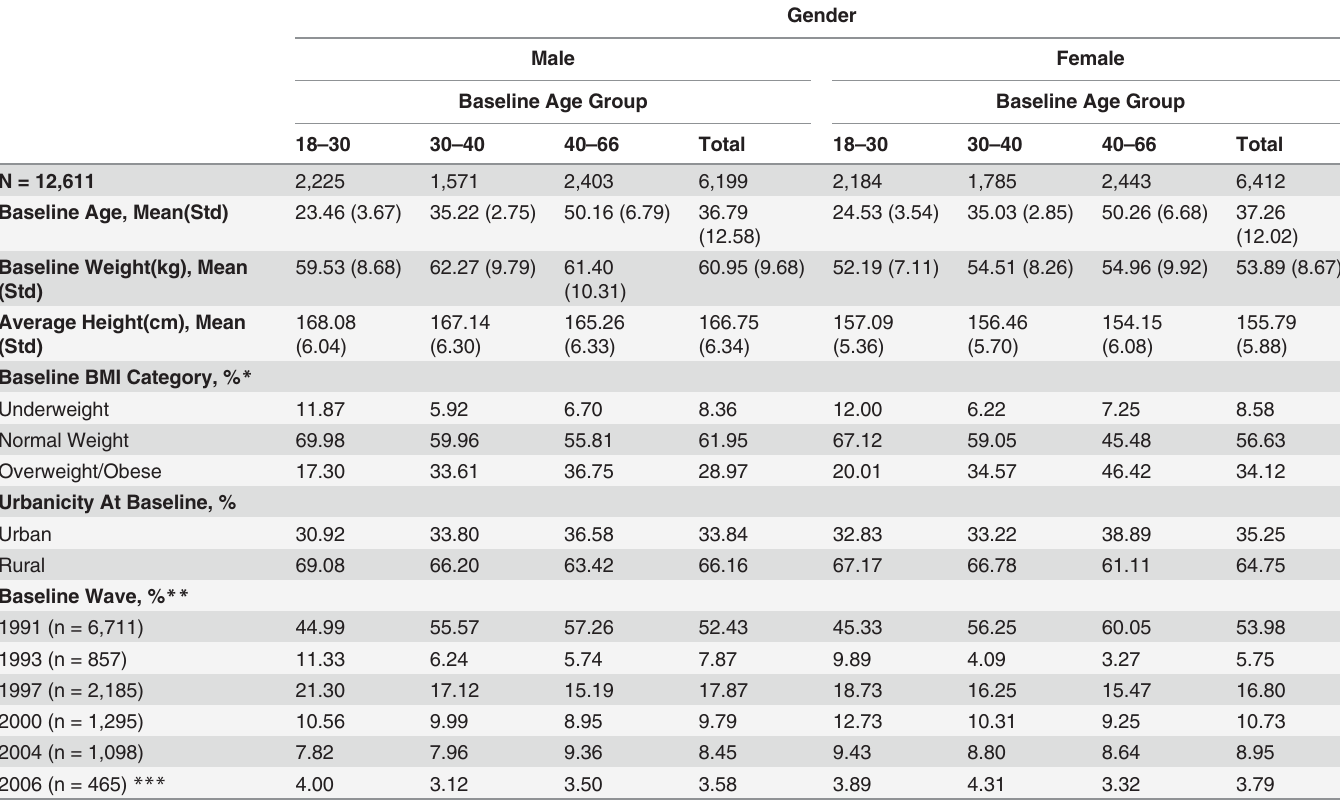
Table 1. Descriptive Statistics for Baseline Covariates by Gender and Age-Group, China Health and Nutrition Survey.